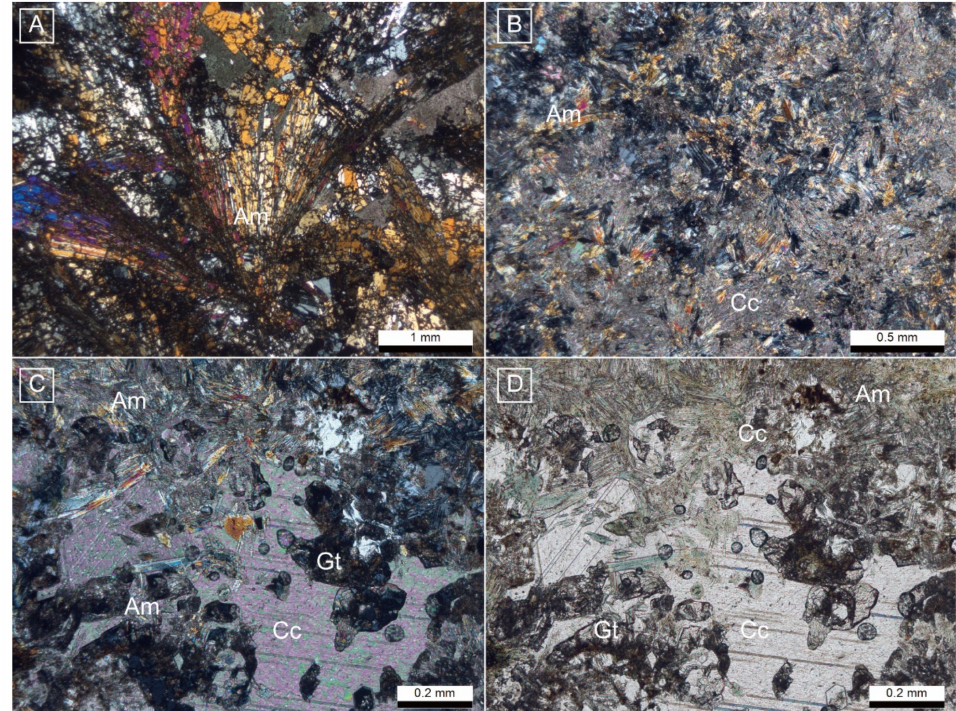
Figure 7. Microphotographs of amphibole skarn ( A – C ) are under crossed nicols; ( D ) is under open nicol). Amphibole (Am) occurs as a prismatic radial aggregate ( A ) and a fibrous aggregate ( B ). Fibrous amphibole aggregate overprints calcite (Cc) matrix and fragmented garnet (Gt). Plotting to the discrimination diagram of amphibole, they are classified as actinolite and ferro-actinolite (Figure